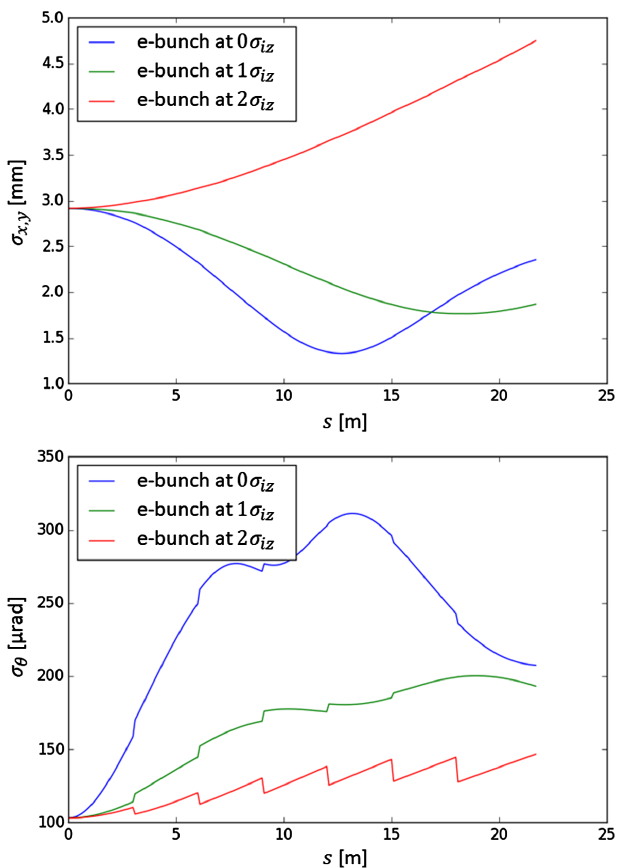
FIG. 5. RMS size (top) and rms angular spread of the electron bunches longitudinally placed at 0 σ iz (blue), 1 σ iz (green) and 2 σ iz (red) of the ion bunch. The results are shown for the experimental parameters listed in Table